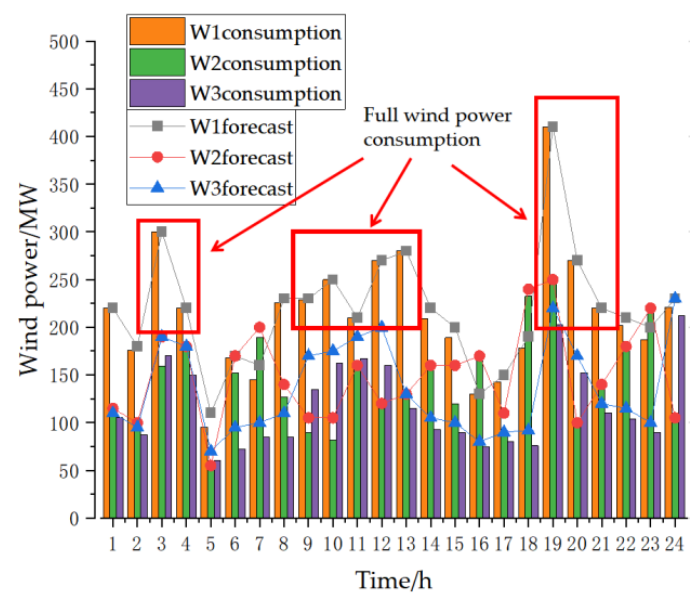
Figure 8. Wind farm accommodation in Case 1.